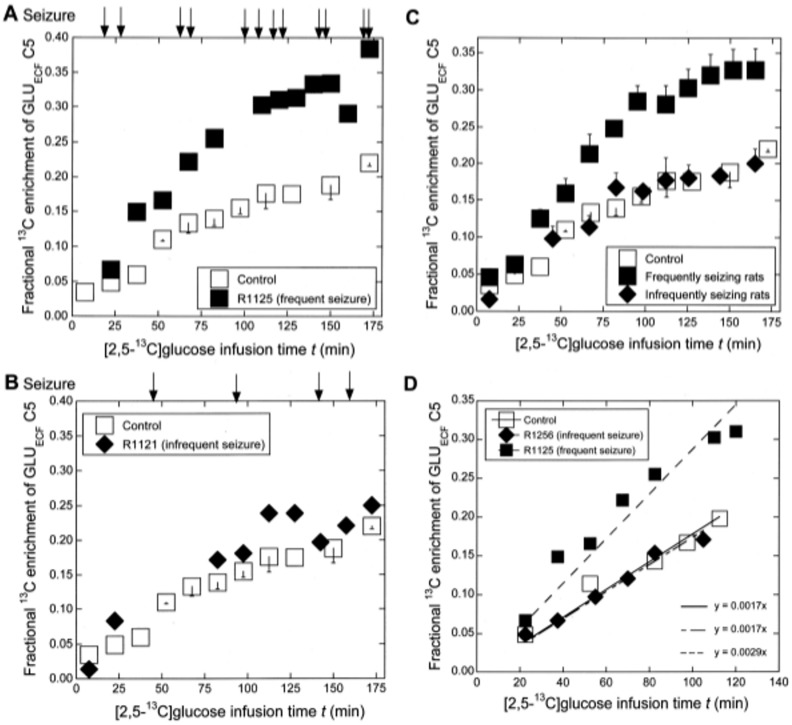
The time course of 13C enrichment of GLUECF C5.A. A representative time course in a frequently seizing KA rat (R1125: black square) compared to control (open square). In this rat, the seizures occurred at the times shown by arrows. The mean ± SE of the number of seizures in the frequently seizing KA rats is provided in Table 1, while the mean time course of the 13C enrichment of GLUECF C5 for this group is shown in Fig 3C. B. Time course (black diamond) in a representative KA rat with rare seizures (R1121; shown by arrows) compared to control (open square). The mean ± SE of the number of seizures in the infrequently seizing KA rats is provided in Table 1, while the mean time course of the 13C enrichment of GLUECF C5 in this group is shown in Fig 3C. C. Time course shown as the mean ± SE for controls (n = 6), infrequently seizing rats (n = 6) and frequently seizing rats (n = 4). The 13C enrichment was substantially faster in frequently seizing rats compared to both the control and the infrequently seizing rats. D. The least-squares fit for the calculation of the rate of 13C enrichment for t = 0–120 min for a representative rat from control, an infrequently seizing (R1256), and a frequently seizing (R1125) rat. The mean ± SE values of the rates of 13C enrichment of GLUECF C5 for each group are shown in Table 2.